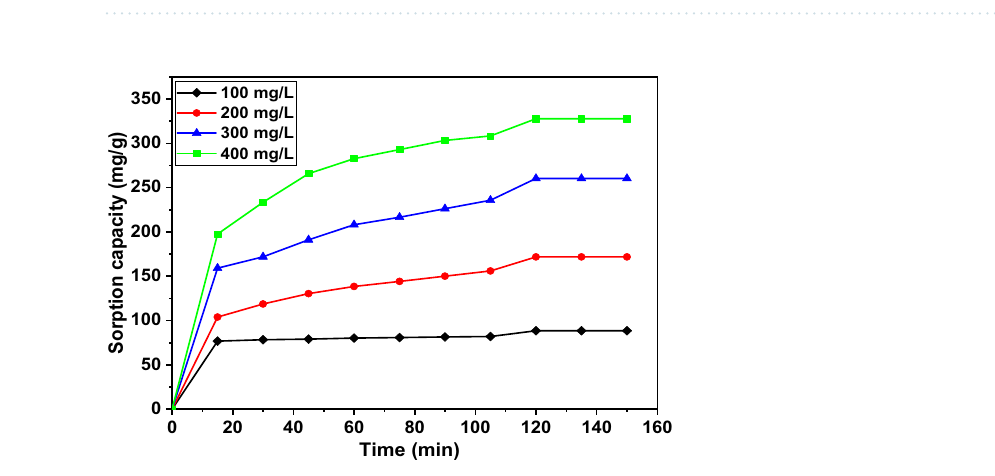
Figure 10. Effect of contact time on 4-CPh sorption with various initial concentrations C 0 = 100 mg/L (filled diamond), 200 mg/L (filled circle), 300 mg/L, (filled triangle) 400 mg/L (filled square).